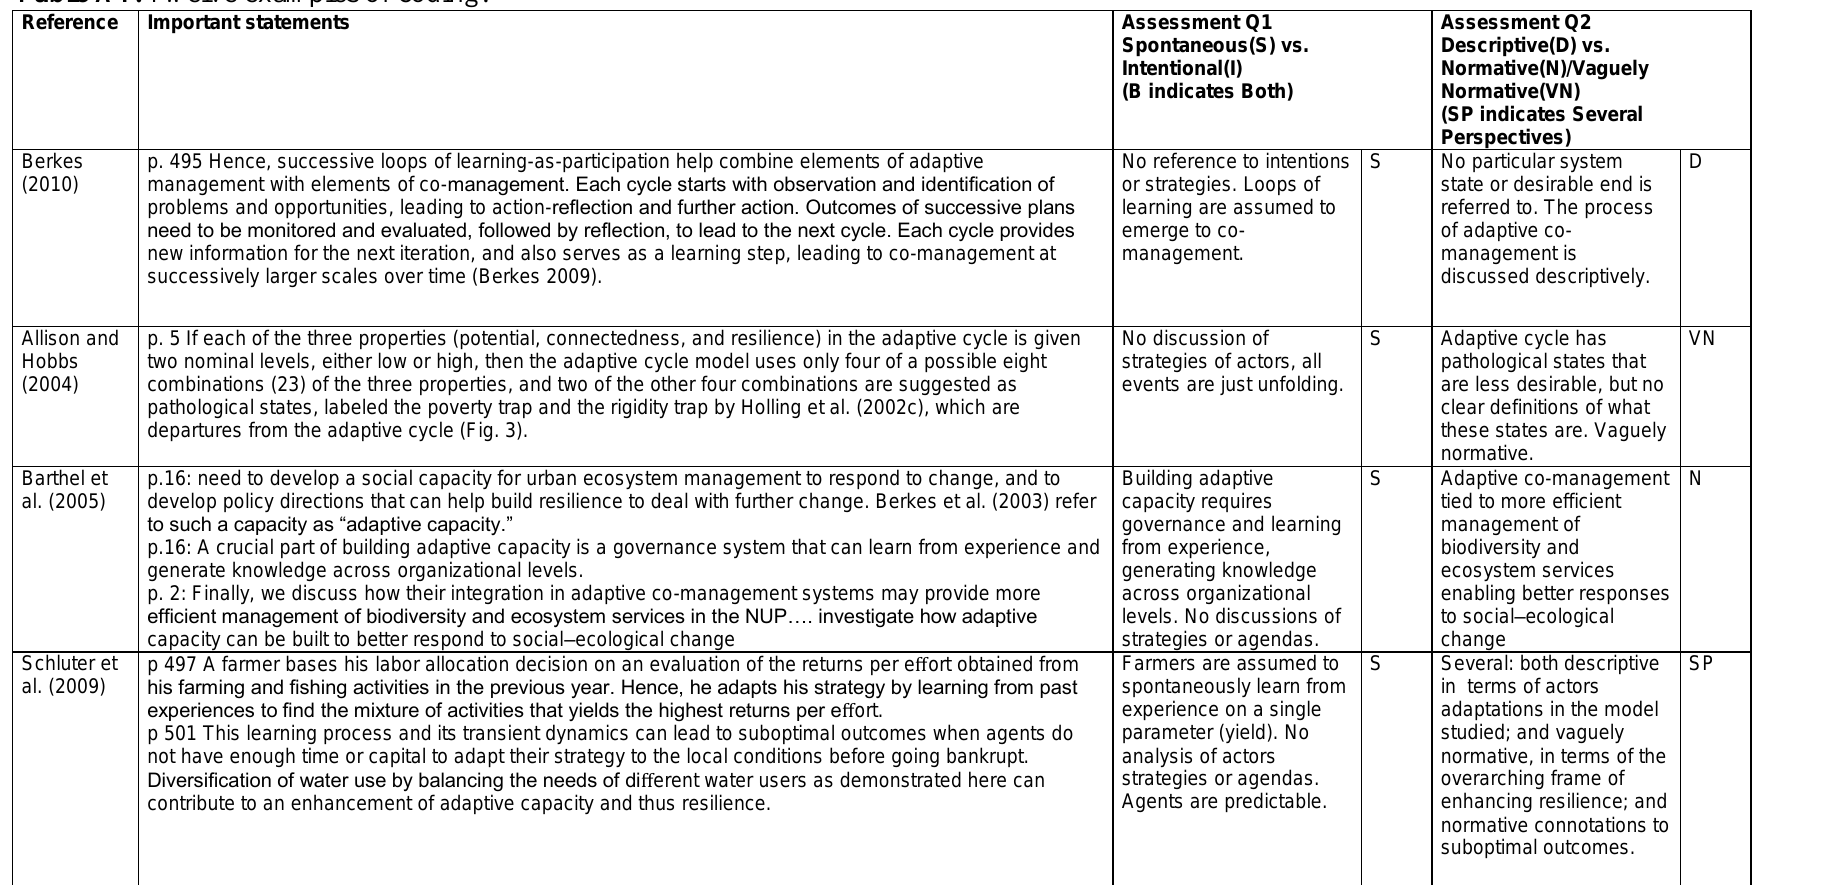
Table A1. Twelve examples of